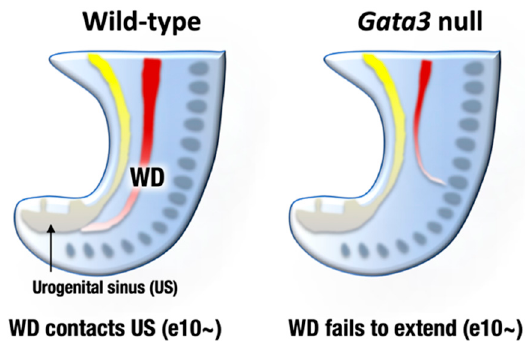
Figure 3. By embryonic day 9–10, mesonephric ducts (WD, Wolffian ducts) extend posteriorly to reach the urogenital sinus (US) that later give rise to bladder and urethra ( left ). Gata3 -deficient mouse embryos fail to extend nephric duct to the US. The atretic remnant of the nephric duct sometimes extends to aberrant direction ( right ). Consequently, metanephric kidney development is disturbed in the Gata3 -deficient embryos.